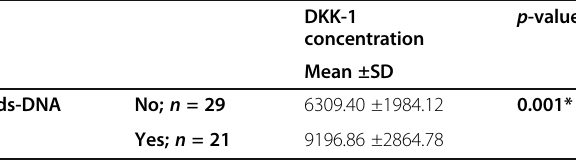
Table 2 Comparison of DKK-1concentration in Anti-double strand DNA positive and Anti-double strand DNA negative in Studied SLE Patients; ( N = 50) DKK-1